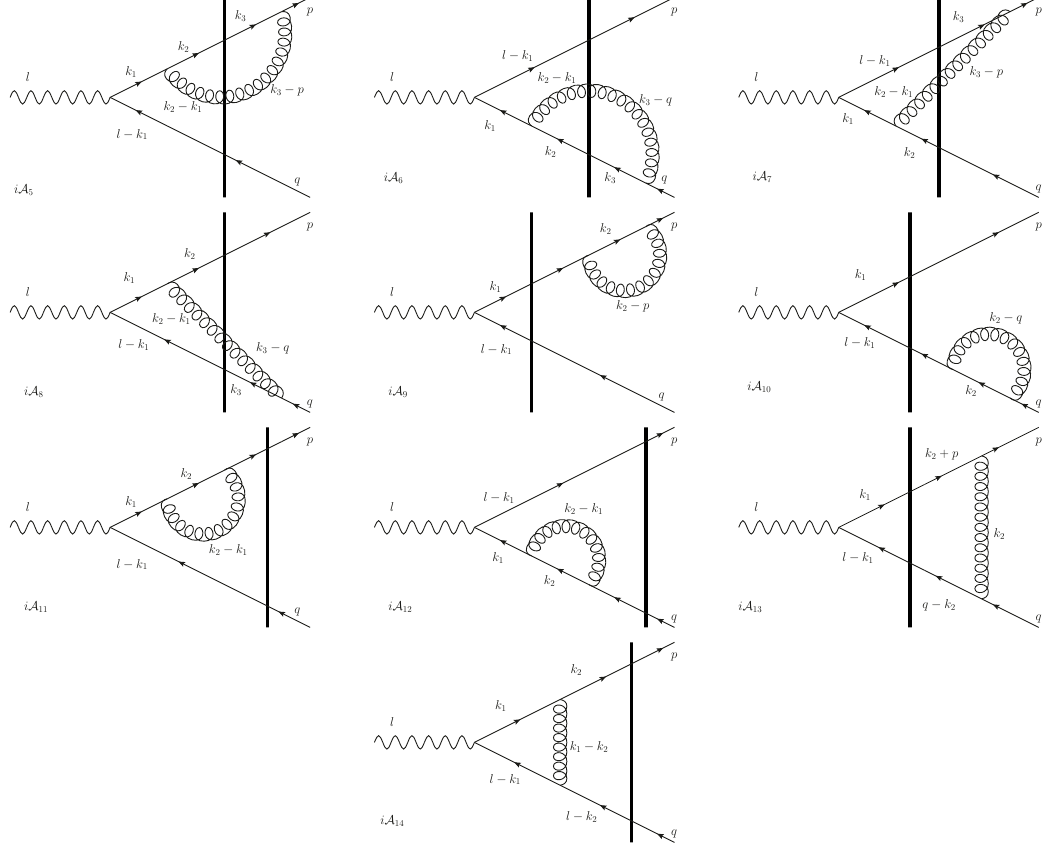
Figure 2 . The ten virtual NLO diagrams i A 5 , . . . , i A 14 . All momenta flow to the right, except for gluon